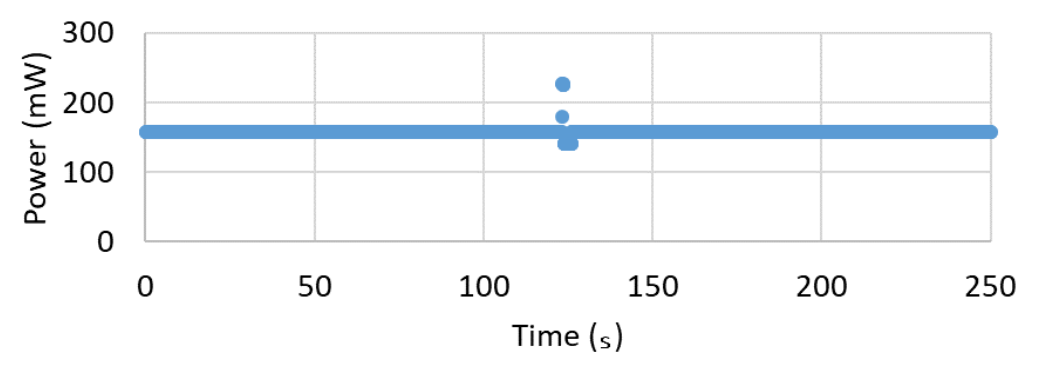
Figure 7. Power versus Time shows consistent 157 mW excepting an anomalous spike which is currently